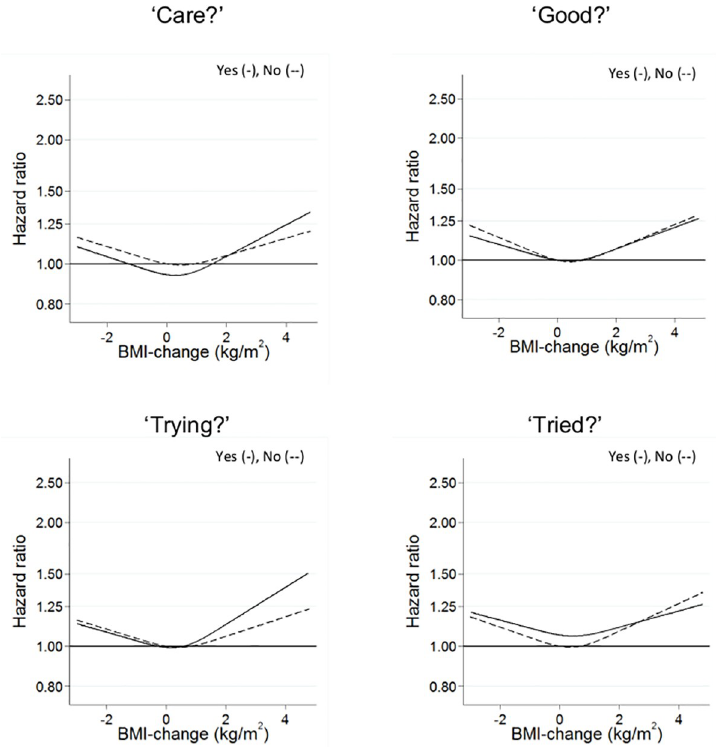
Fig 3. Body weight control, changes in body weight and all-cause mortality in relation to body weight control questions in an overweight population; Yes (-), No (--).